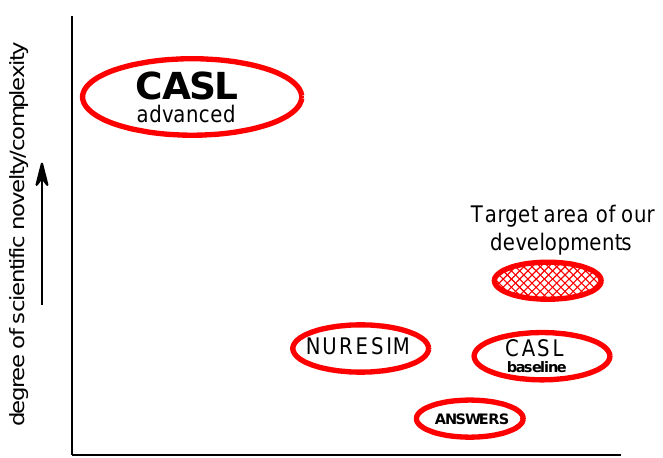
Figure 2. Where we plan to place the new development for the U.K. in comparison with national and international projects.